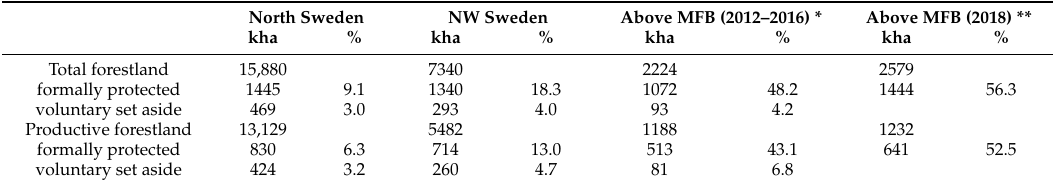
Table 1. Total and productive forestland area, and the proportion (%) formally protected and voluntary set aside area according to NFI (2012–2016, 5-year average) (*), and total and productive forestland area, and the proportion formally protected area according to SCB [50] (**), presented for north Sweden, northwest (NW) Sweden, and the region within NW Sweden above the mountain forest border (MFB) in 1000